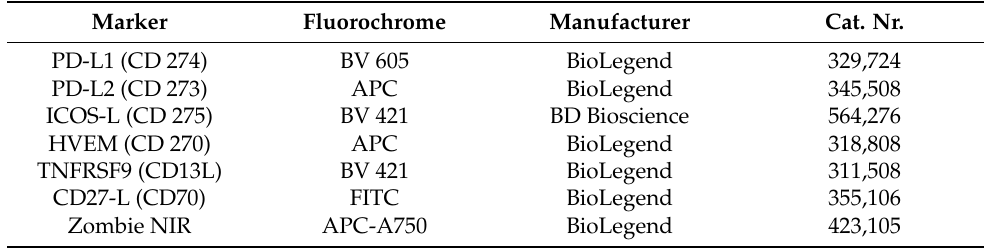
Table 1. List of antibodies used to analyse the surface expression of the immune checkpoint molecules by multicolor flow